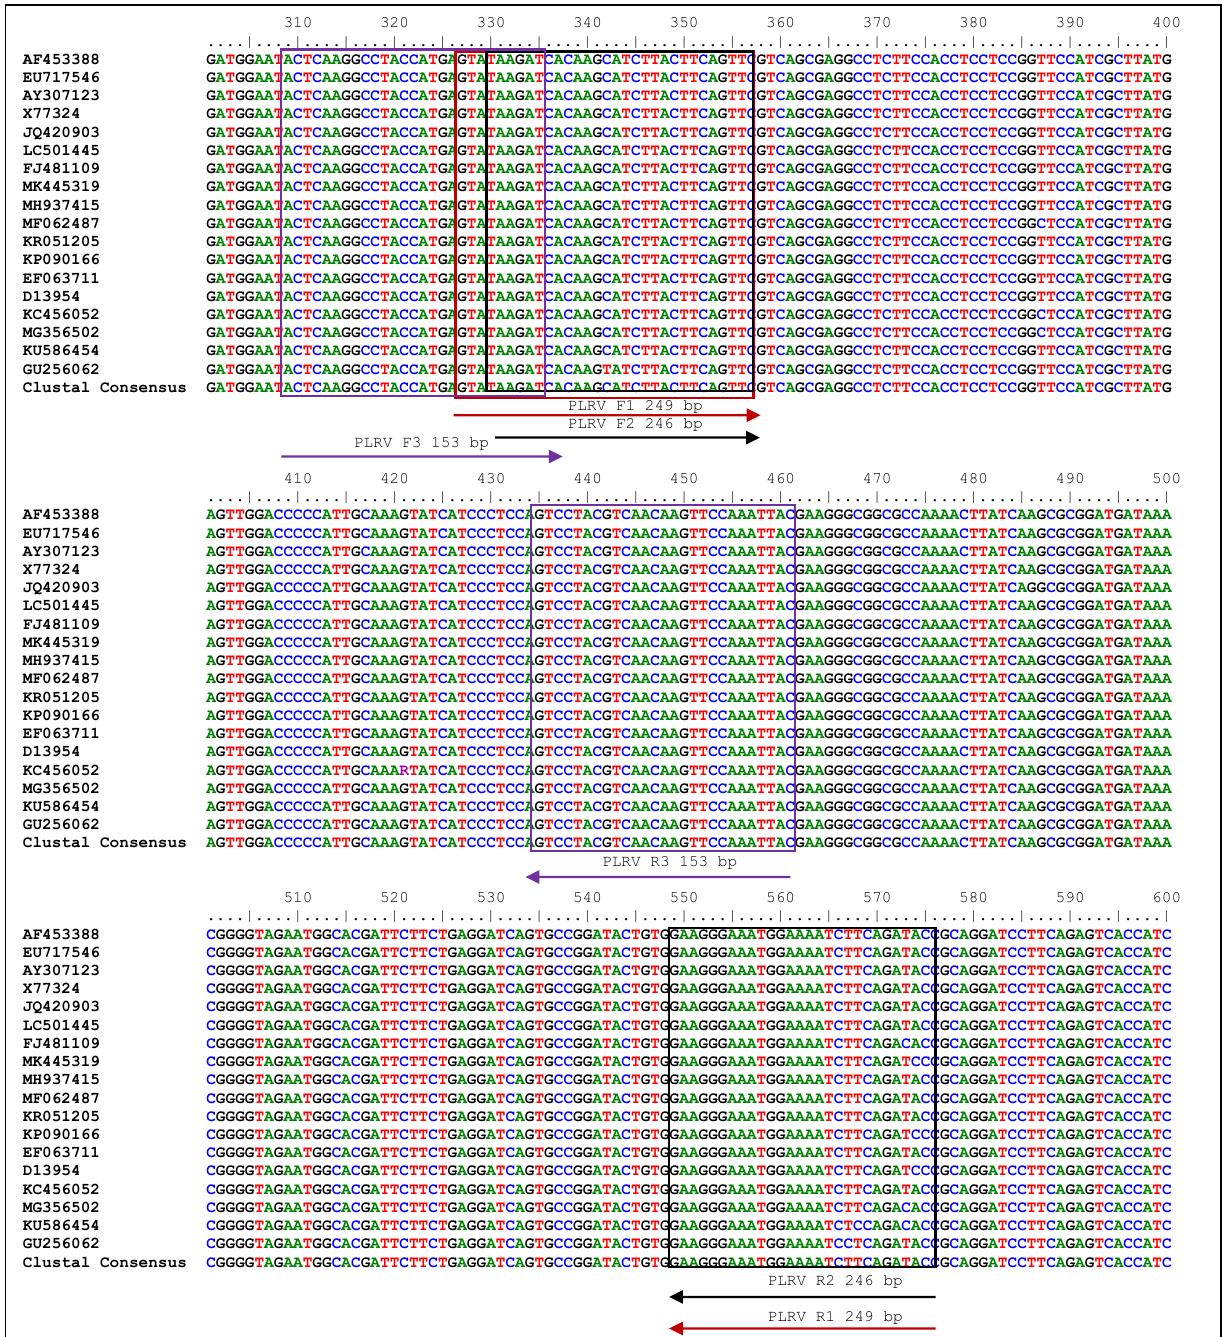
CGGGGTAGAATGGCACGATTCTTCTGAGGATCAGTGCCGGATACTGTGGAAGGGAAATGGAAAATCTTCAGATACCGCAGGATCCTTCAGAGTCACCATC EU717546